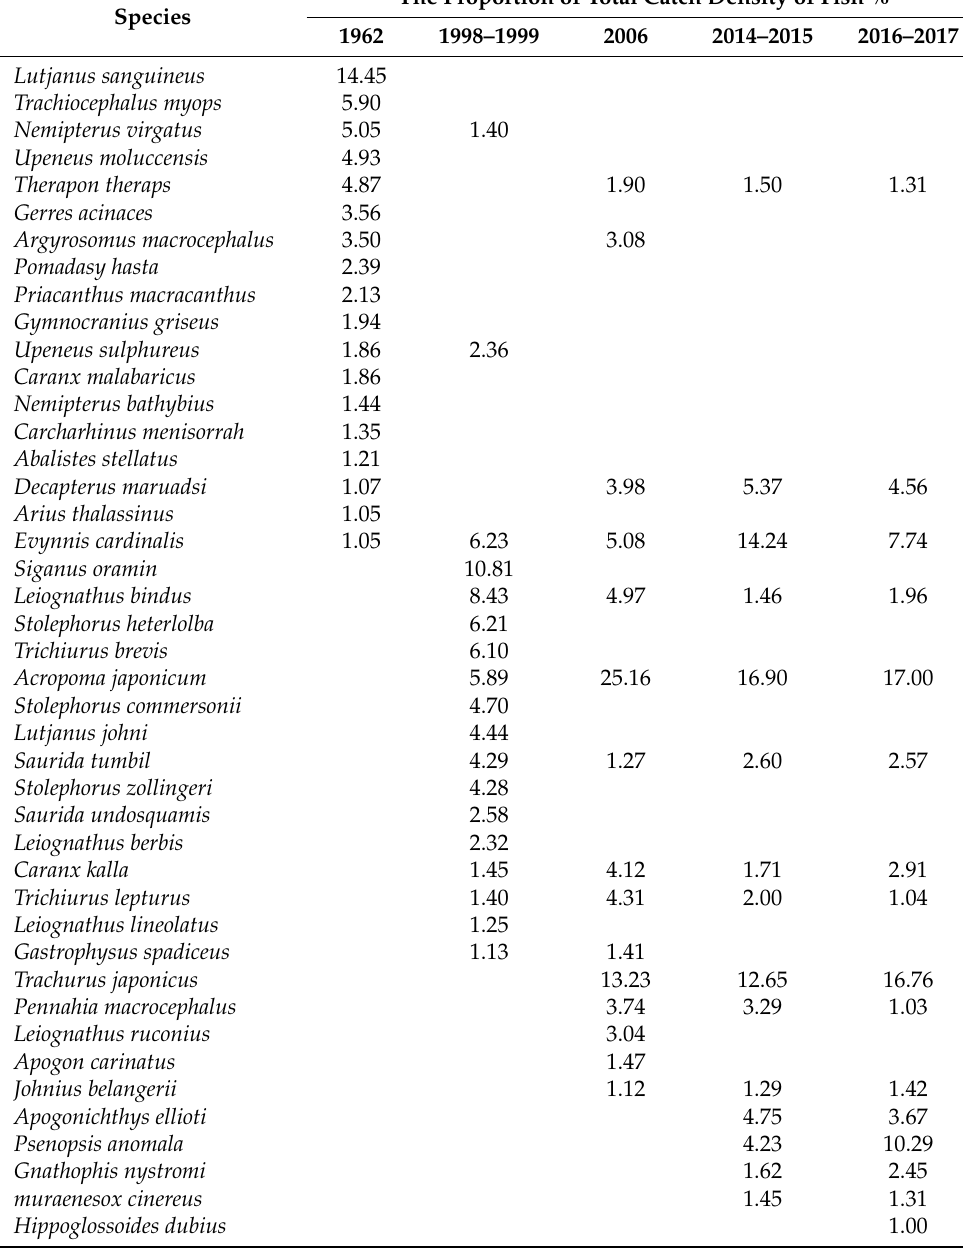
Table 3. The species accounted for >1% of total fish catch density in the surveys. The Proportion of Total Catch Density of Fish Species